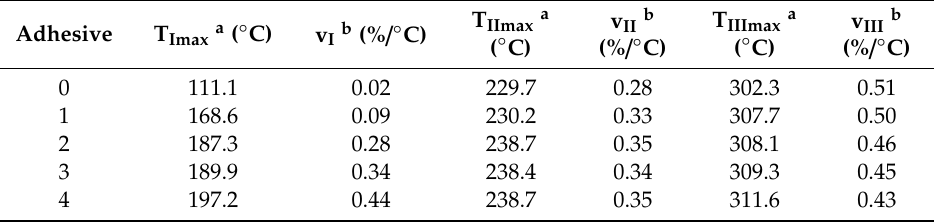
Table 2. Thermodegradation data of the di ff erent adhesives: 0 (SM adhesive), 1 (SM / DRE-2 adhesive), 2 (SM / DRE-4 adhesive), 3 (SM / DRE-6 adhesive), 4 (SM / DRE-8 adhesive).